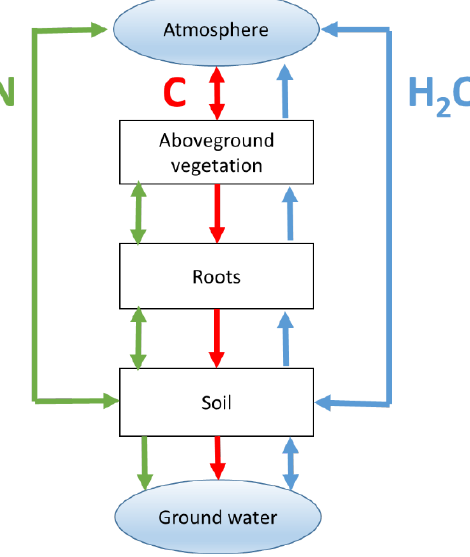
Figure 2. The typical structure of a biogeochemistry model (BGM).